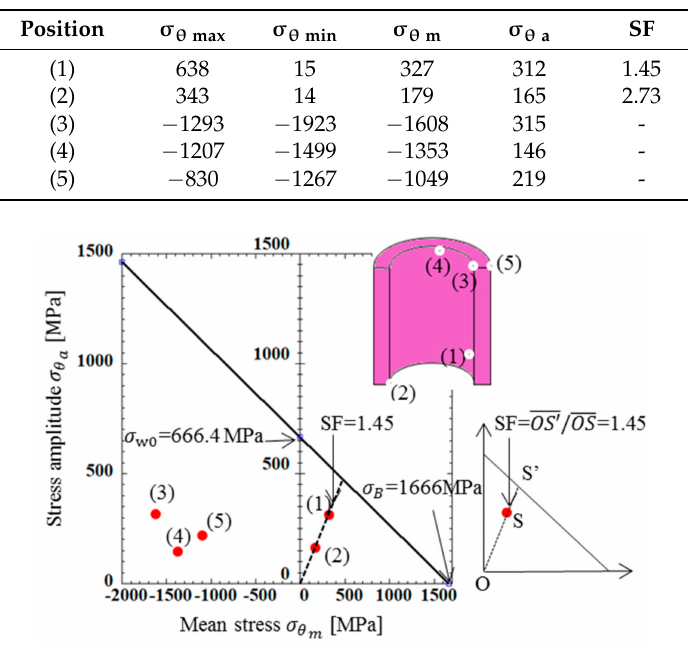
Table 4. Maximum stress σ θ max and minimum stress σ θ min , mean stress σ θ m and stress amplitude σ θ a for bush [MPa].